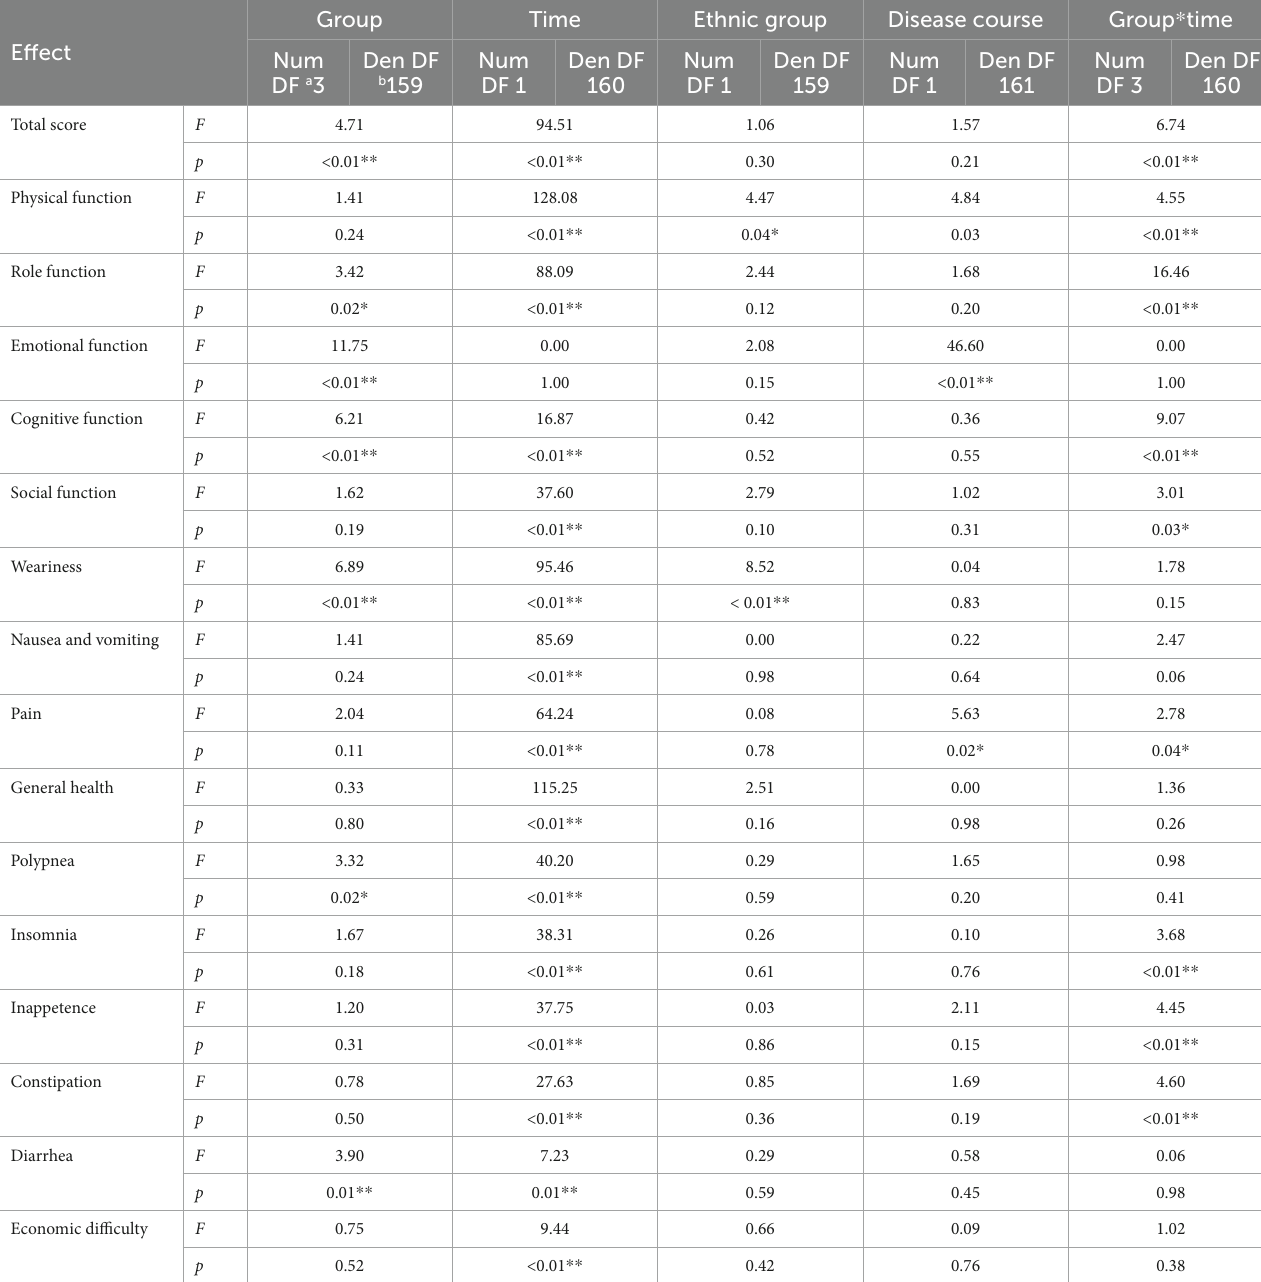
TABLE 3 Type III fixed effects of quality of life ( n =